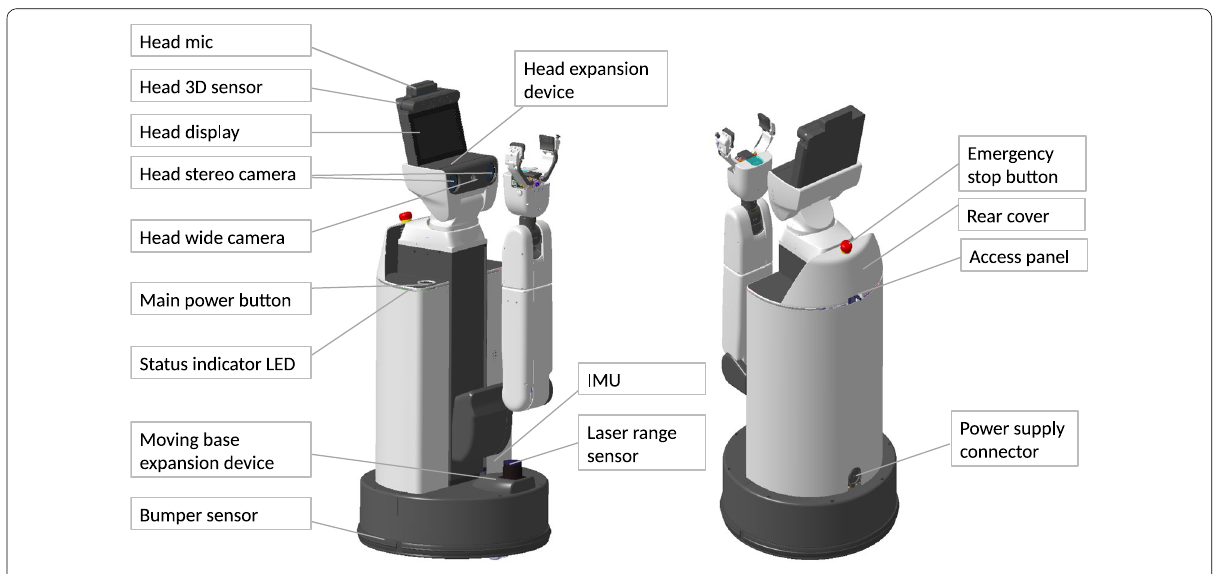
Fig. 14 Sensors and equipments of HSR [3]